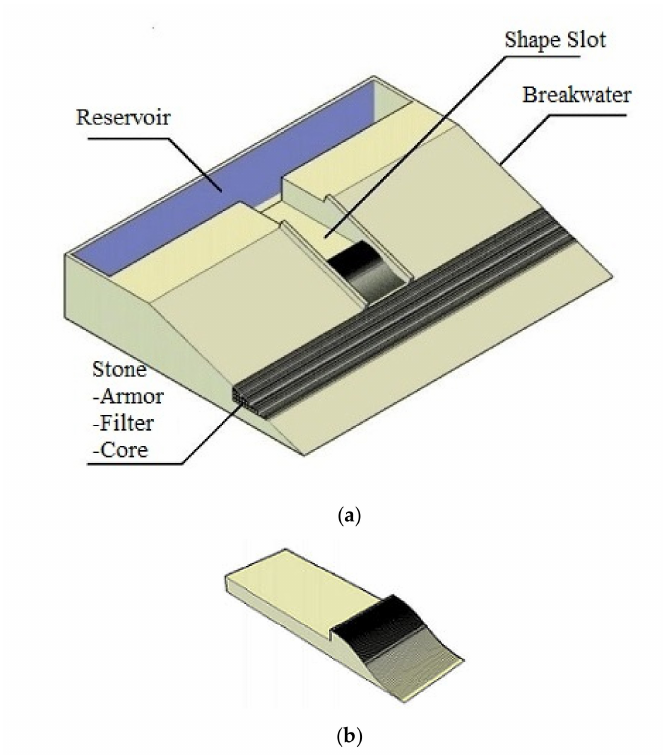
Figure 3. ( a ) Main body of OBREC device model. ( b ) Ramp shape